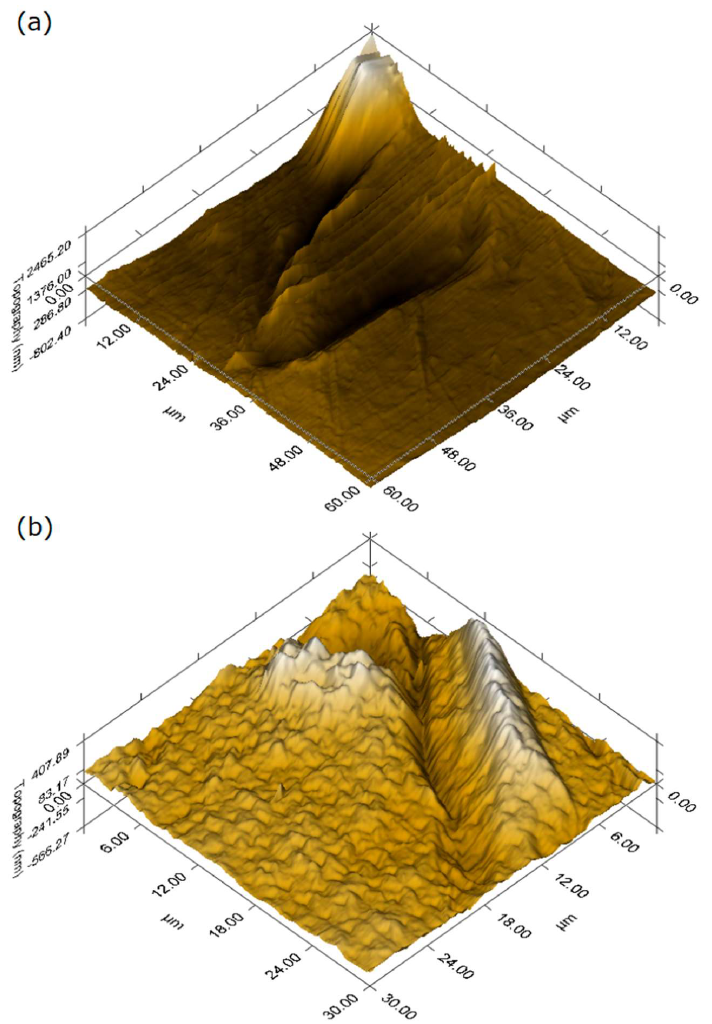
Figure 3. In-situ scanning probe microscopy (SPM) imaging of PVDF–SSPF composites. ( a ) 3D direct measurement of surface topography of up to 60 µm; ( b ) high-resolution topography mapping with another length scale of up to 30 µm.